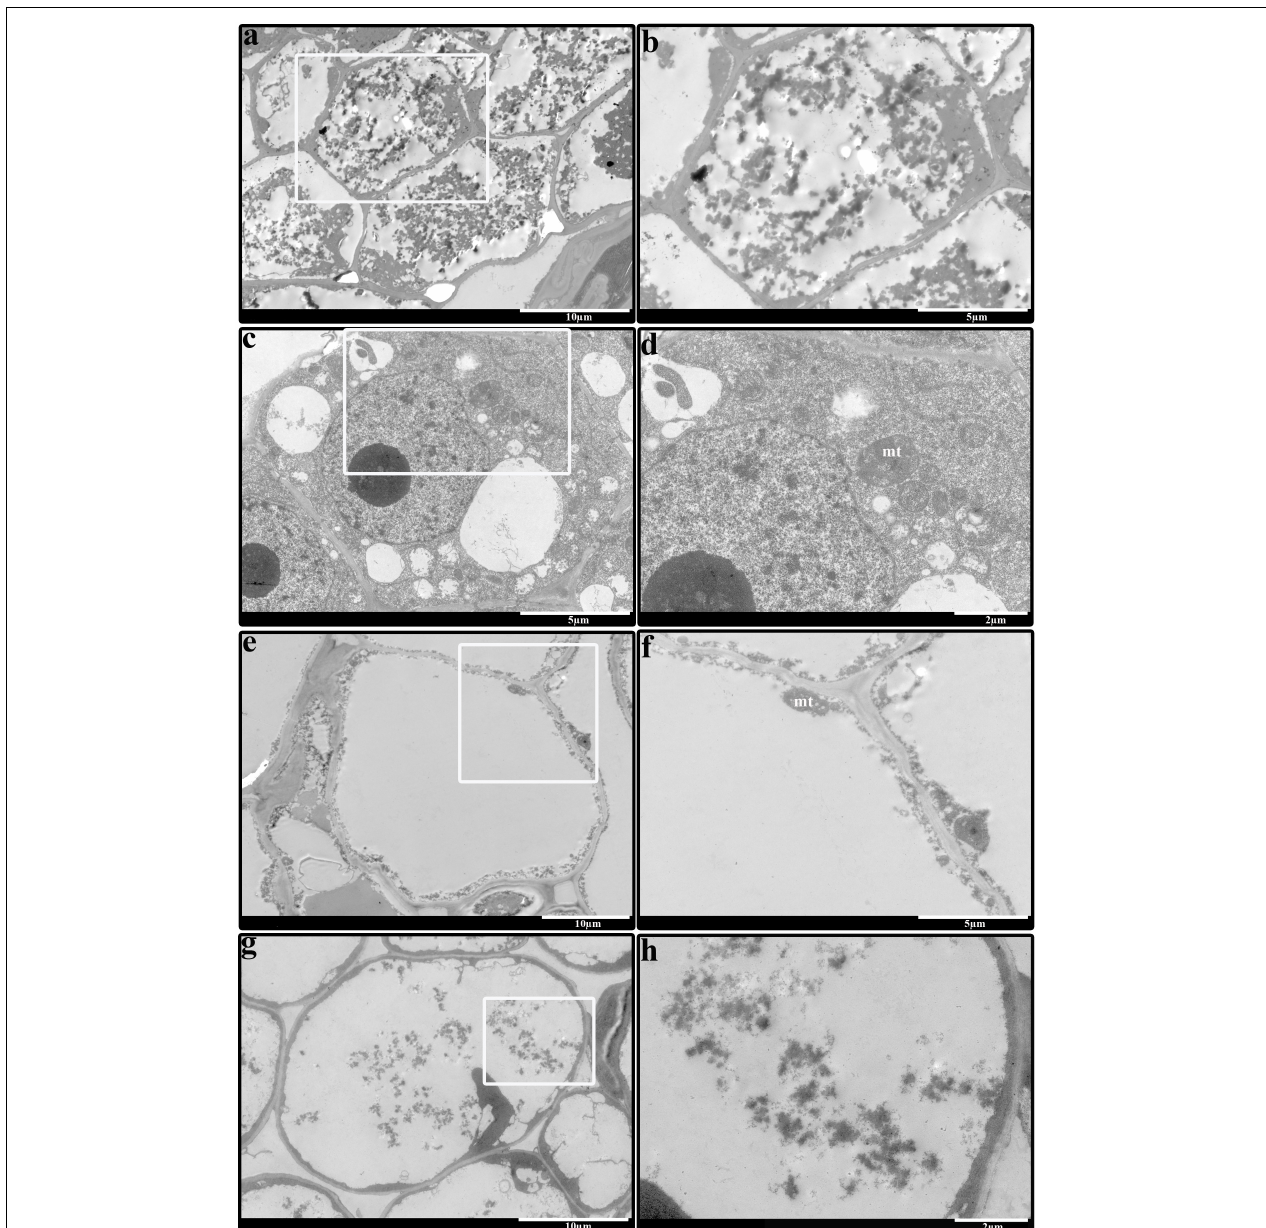
FIGURE 2 | Comparison of stamen and aborted pistil in androecious persimmon flowers. (a) Electron microscopic structure of the stamen from a sample treated with 1,000 mg/L ethrel. (b) Magnified image highlighted in (a) . (c) Electron microscopic structure of the stamen from an untreated sample. (d) Magnified image highlighted in (c) . (e) Electron microscopic structure of the aborted pistil from a sample treated with 10 mg/L ZT. (f) Magnified image highlighted in (e) . (g) Electron microscopic structure of the aborted pistil from an untreated sample. (h) Magnified image highlighted in (g) . mt,